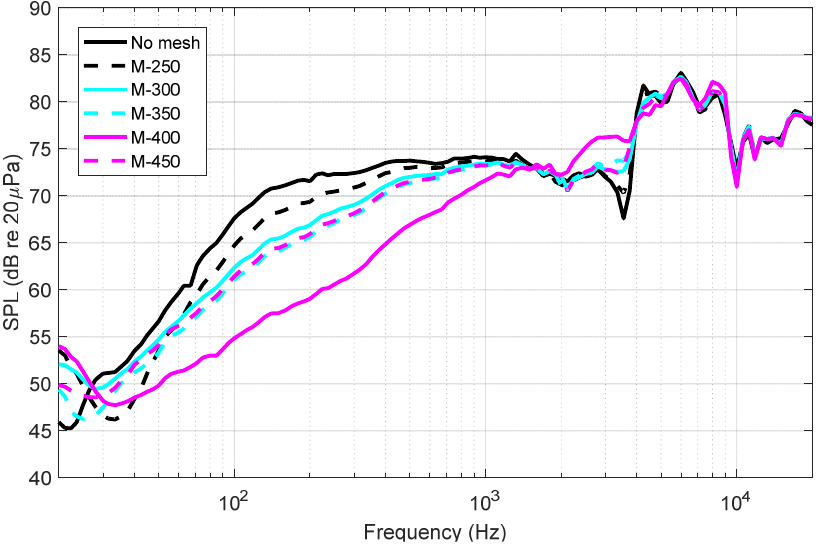
Figure 8. Measured frequency responses of microspeaker without and with meshed ventilation cloths (M-250 to M-450).